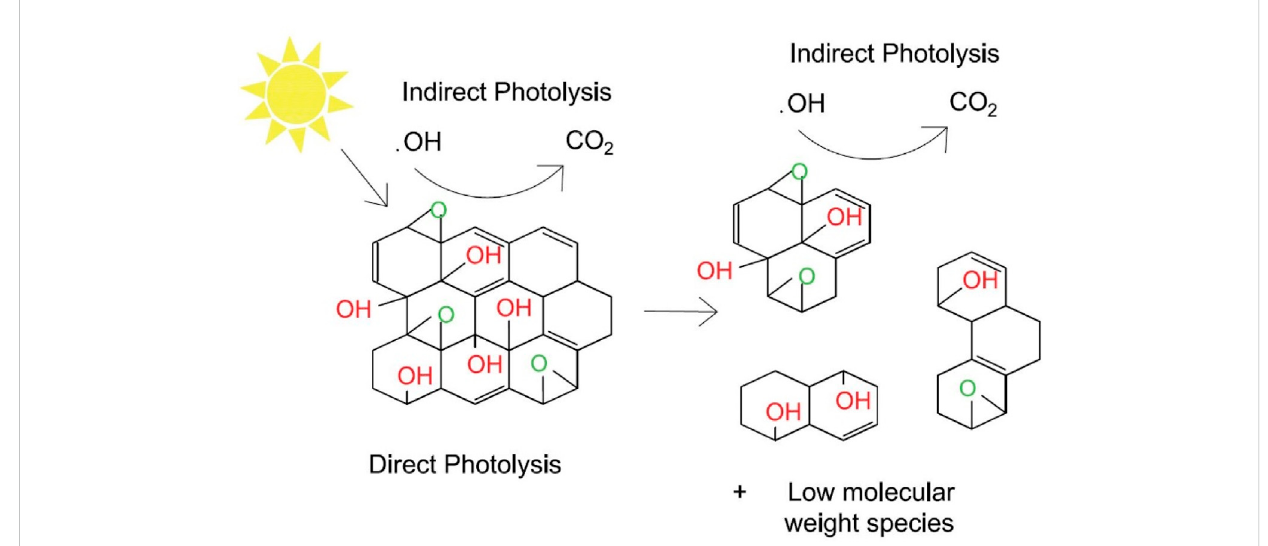
FIGURE 4 Pathways of direct and indirect photolysis of GO under sunlight. Reproduced with permission from W.-C. Hou, I. Chowdhury, D. G. Goodwin, W. M. Henderson,D.H.Fairbrother,D.BouchardandR.G.Zepp,Environ.Sci.Technol.,2015,49,3435 – 3443.Copyright2015,AmericanChemicalSociety(Hou et al., 2015). Reproduced with permission from Carbon, 110, Wen-Che Hou, W. Matthew Henderson, Indranil Chowdhury, David G.Goodwin, Xiaojun Chang, Sharon Martin, D. Howard Fairbrother, Dermont Bouchard, Richard G. Zepp, The contribution of indirect photolysis to the degradation of graphene oxide in sunlight, 426 – 437, Copyright 2016, with permission from Elsevier (Hou et al., 2016). Structures produced by AutoCAD